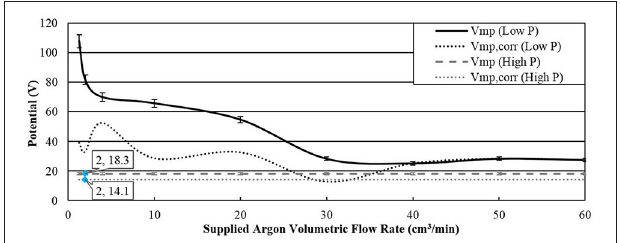
FIGURE 4 | Most probable voltages, corrected (Vmp, corr) and uncorrected (Vmp) at the “Low-Pressure” (Low P) and the “High-Pressure” (High P)